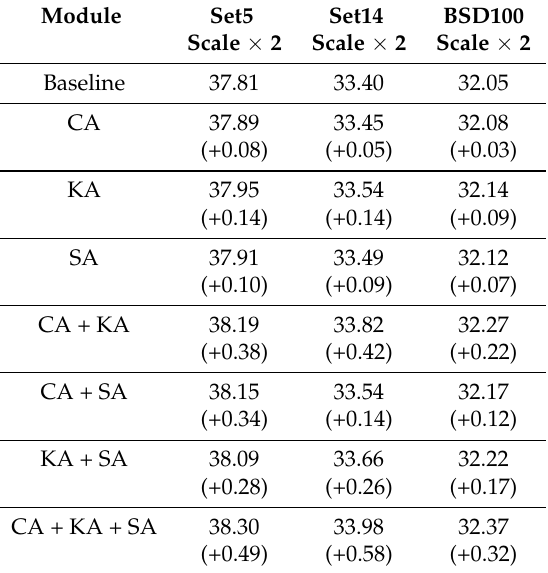
Table 3. Performance comparison of networks with different attention